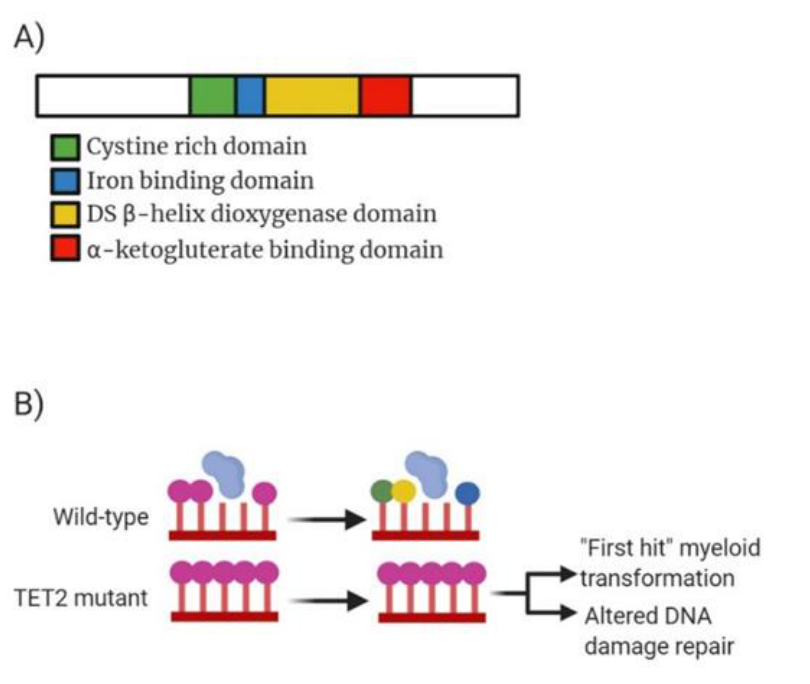
Figure 3. Analysis of TET2 molecular structure, mechanism of action and drug target action. ( A ) Domain structure of mammalian TET2 enzyme consisting of 2002 amino acid residues. Green highlighting a cystine rich domain comprised of two sub-domains which modulate chromatin targeting by TET proteins. Blue highlighting the iron binding domain which interacts with double stranded β -helix domain (yellow) and α -ketoglutarate binding domain (red) to form a core catalytic region. DSBD also contains a low complexity insert whose function remains unclear. ( B ) Mechanism of action for both wild-type TET2 and the mutant TET2 . WT TET2 causing conversion of 5-mC (purple circle) into 5-hmC (green), 5-fC (yellow) or 5-caC (blue). Mutated TET2 lowers expression resulting in overexpression of 5-hmC causing control over genes being switched on or